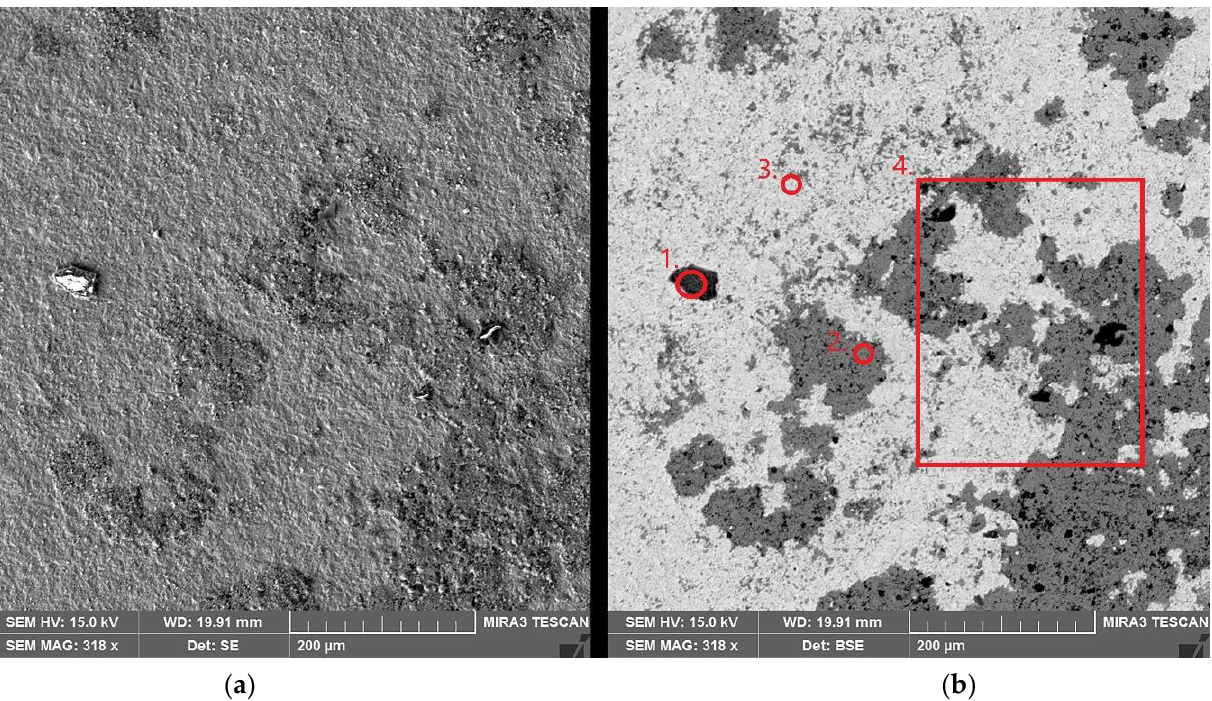
Figure 7. Micrograph of the SS-2 cathode surface ( a ) with EDS analysis points shown on the BSE micrograph ( b ). Numbers indicate the analysis points in Table 7. Table 7. EDS results from the analysis points shown in Figure 7b. No carbon was used in the experiment, but the traces detected by the EDS are from the chamber atmosphere as carbon is commonly sputtered on poorly conductive samples.